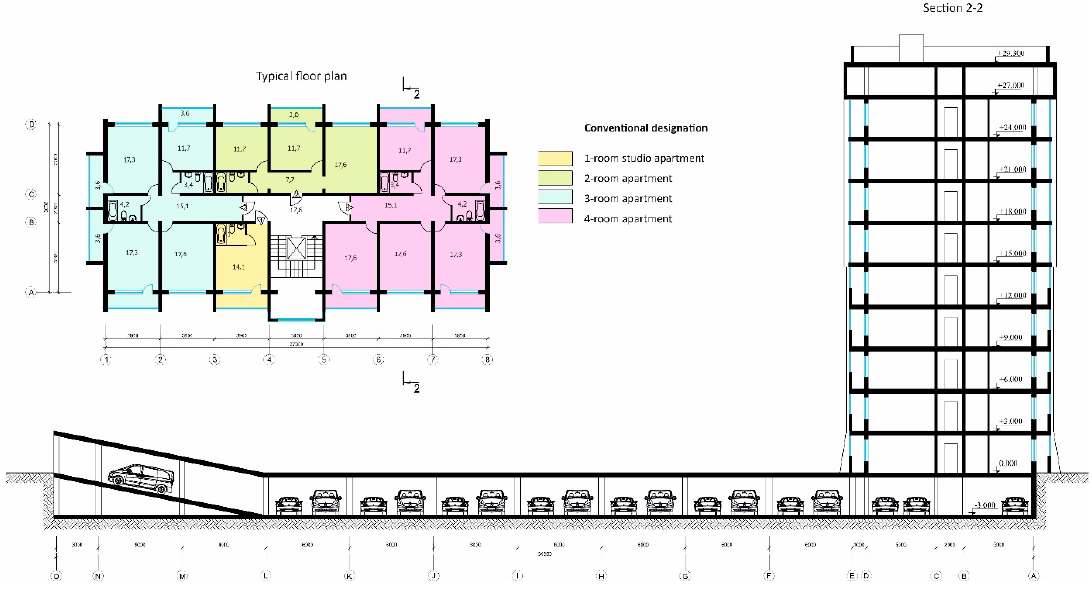
Figure 22. Underground parking with a proposal for the new development of a 9-story residential building (Author’s material).